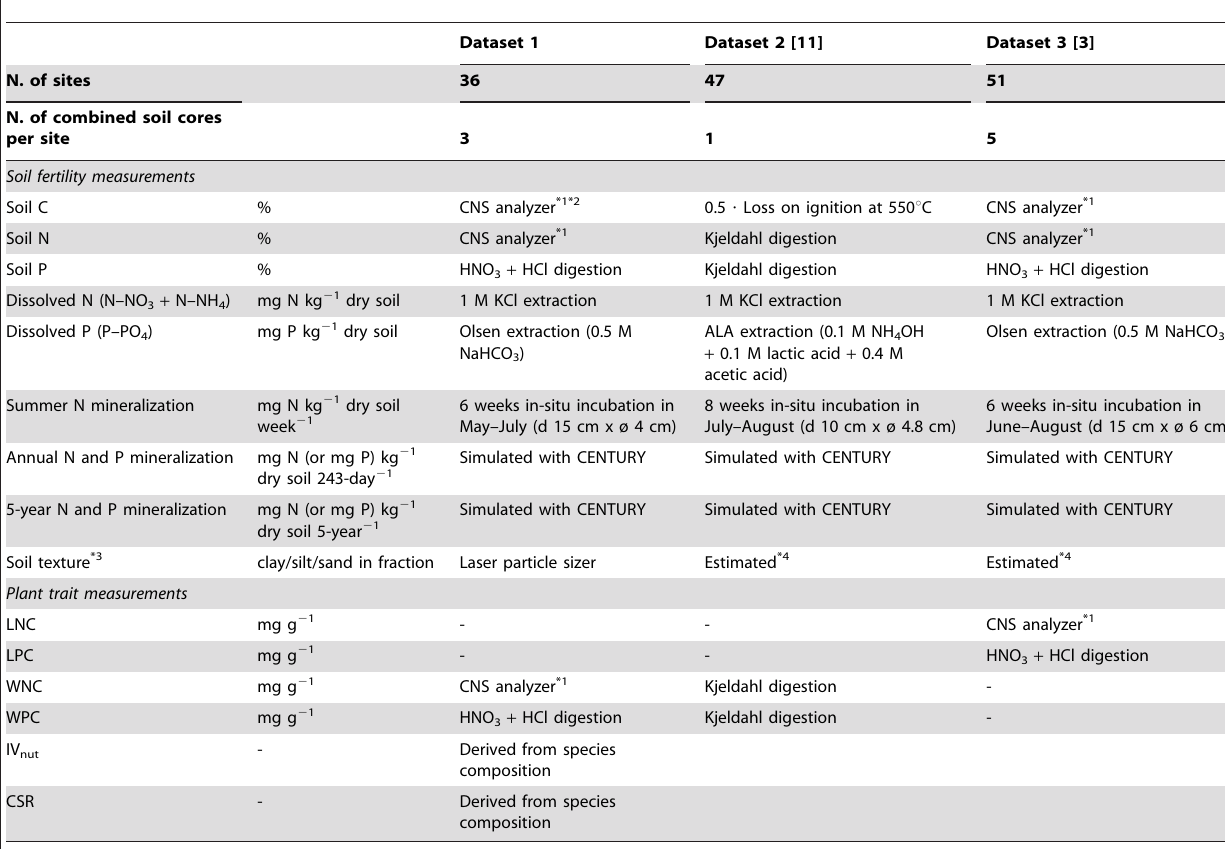
Table 1. Overview of methodology of soil and plant trait measurements for three datasets used in this